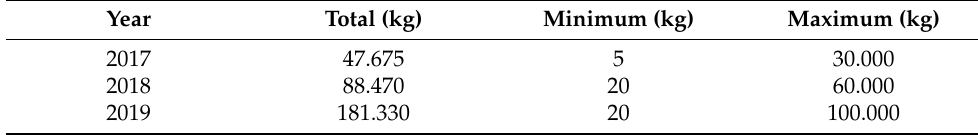
Table 3. Total, minimum and maximum values of dry-aged beef production in Brazil